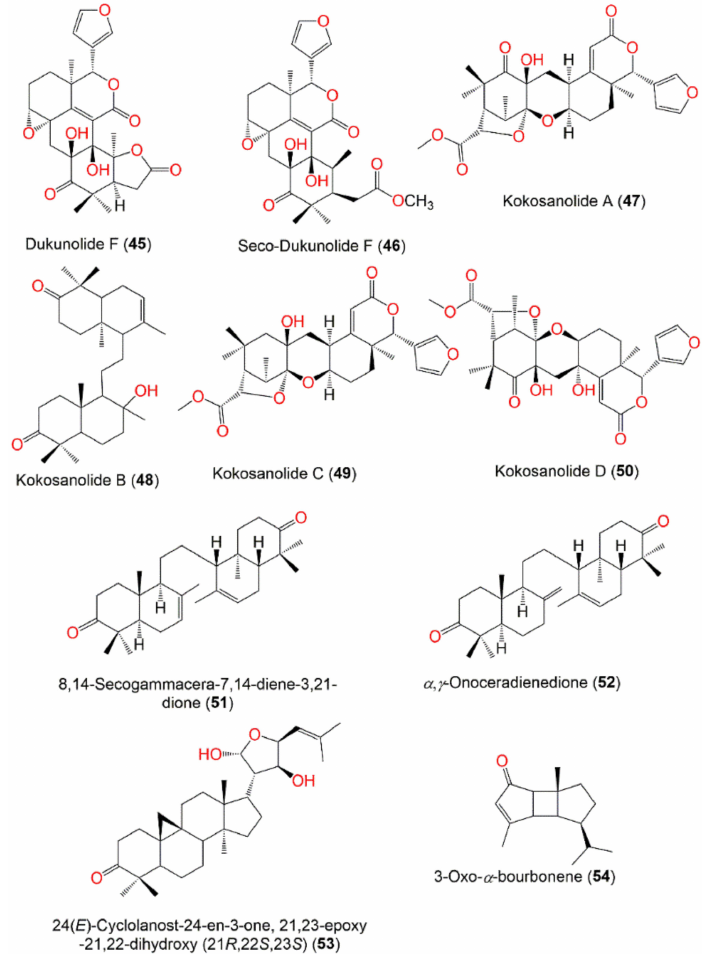
Figure 4. Structures of compounds 45 – 54 from Lansium domesticum